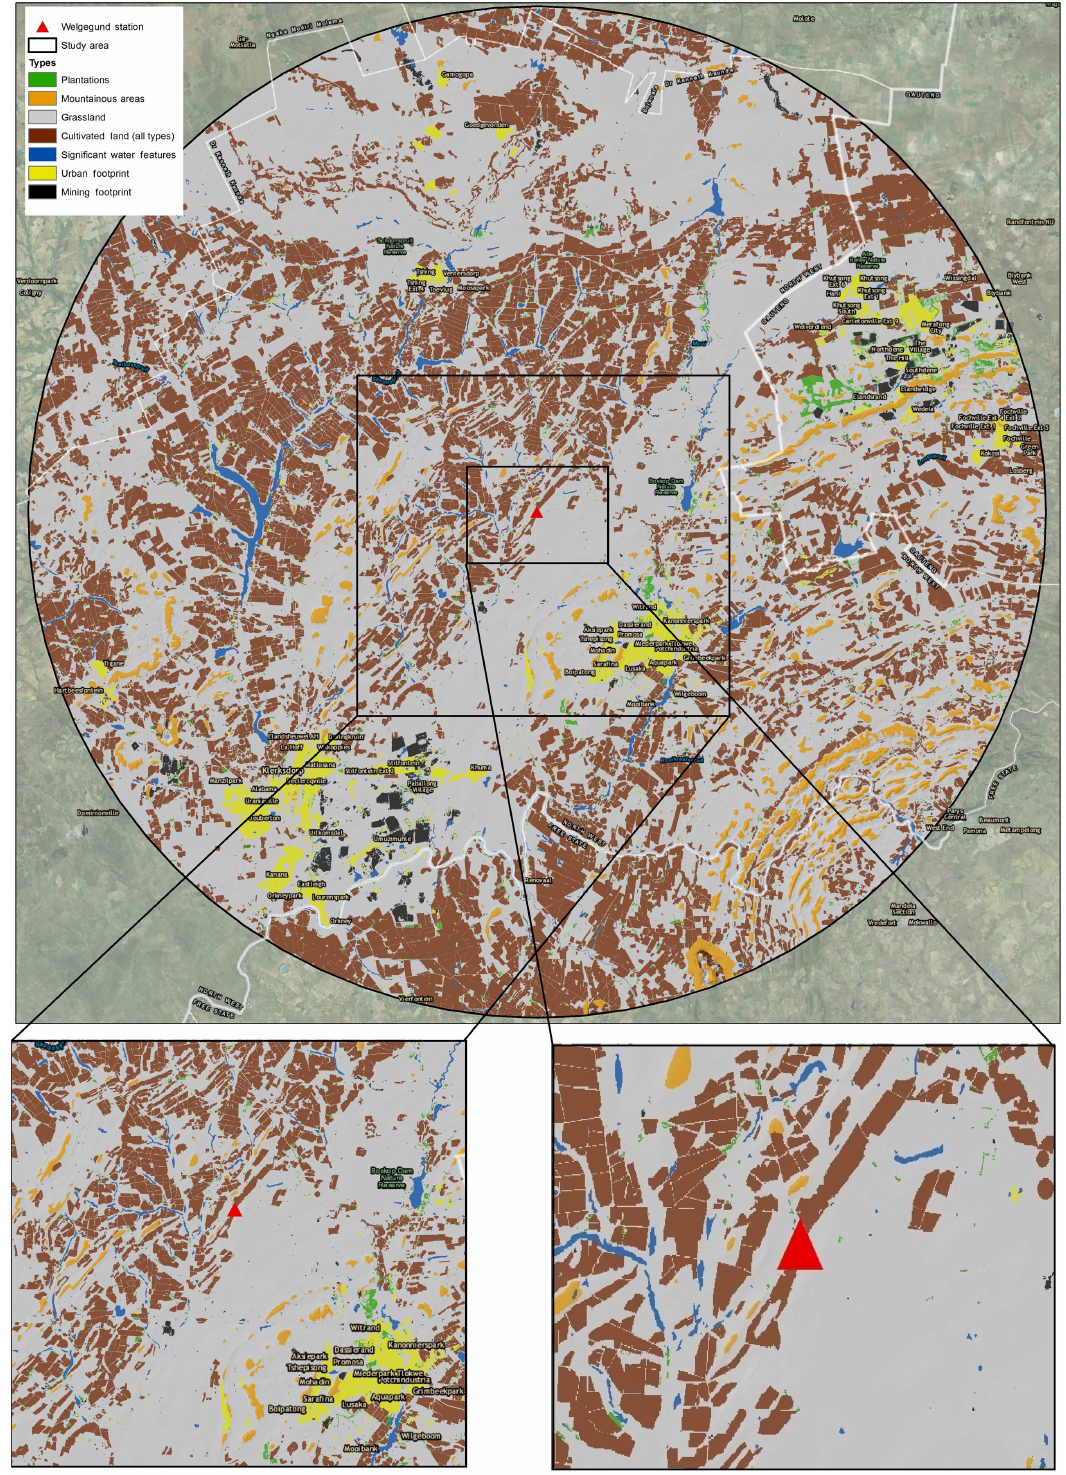
Figure 2. General vegetation map for 60km radius of Welgegund measurement